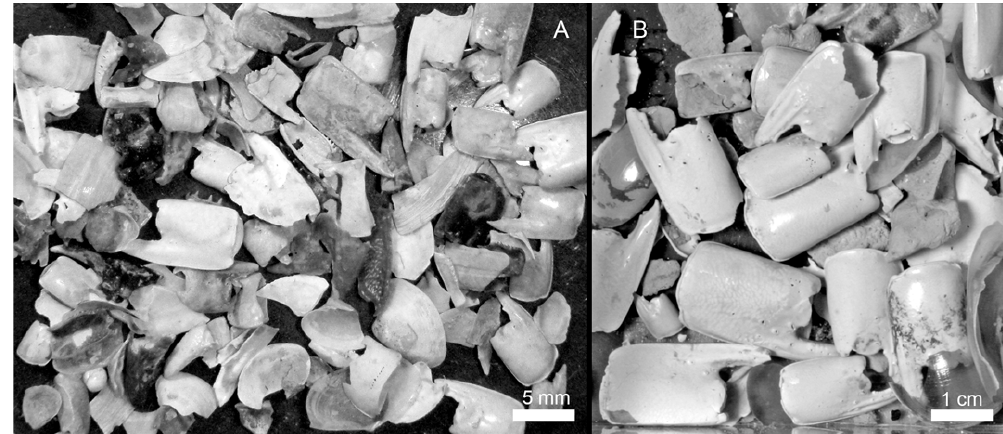
Fig. 8. Residual skeletal assemblage after washing; (A) coarse sand fraction; (B) hash fraction, all from st.